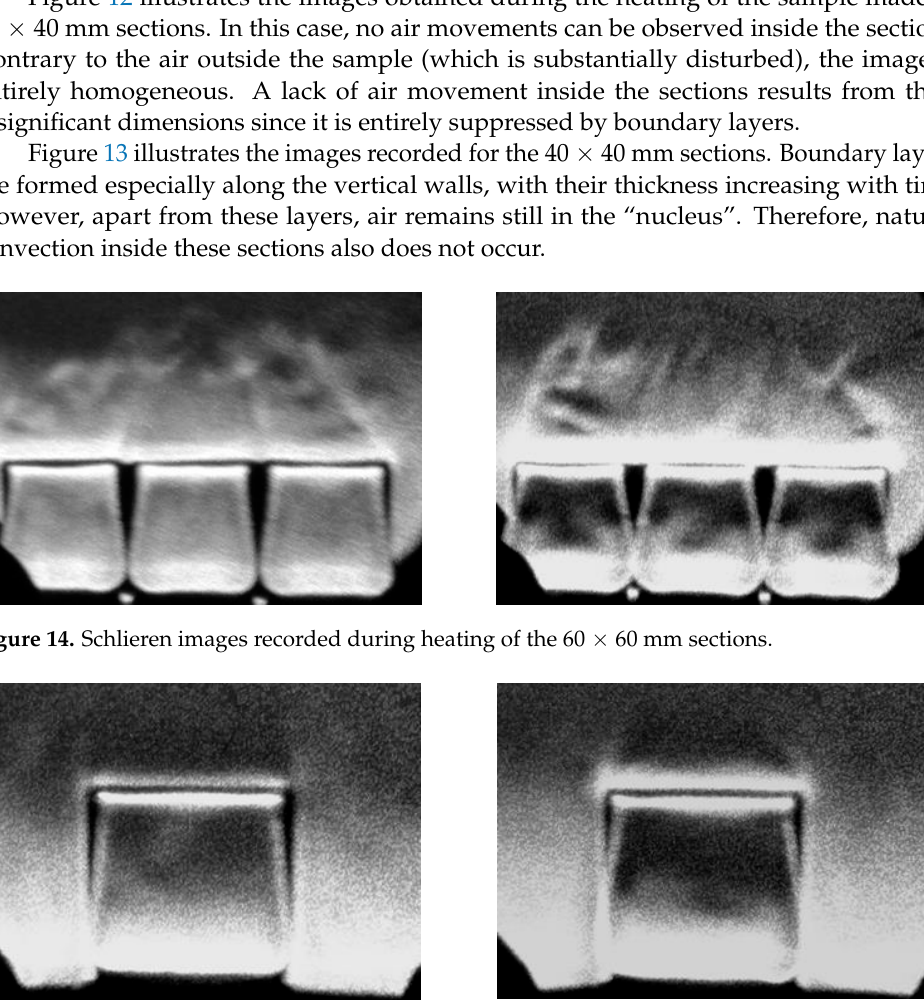
Figure 13. Schlieren images recorded during heating of the 40 × 40 mm sections.